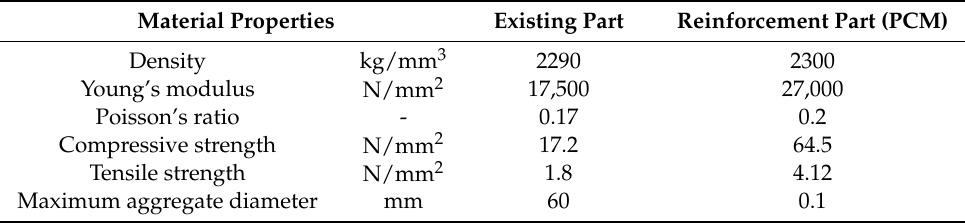
Table 3. Physical characteristics of